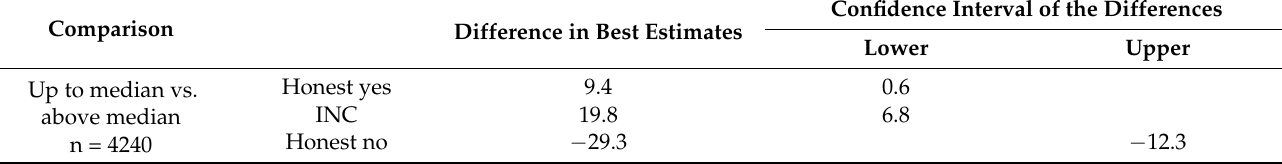
Table 3. Significance test, hypothesis 2: prevalence of doping in recreational sports increases with time spent participating in the sport.